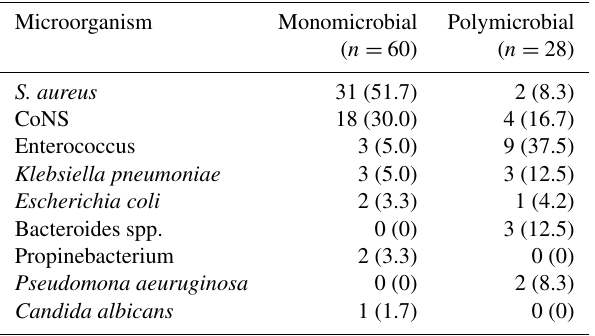
Table 2. Microorganisms identified in hip PJI of the series. Microorganism Monomicrobial